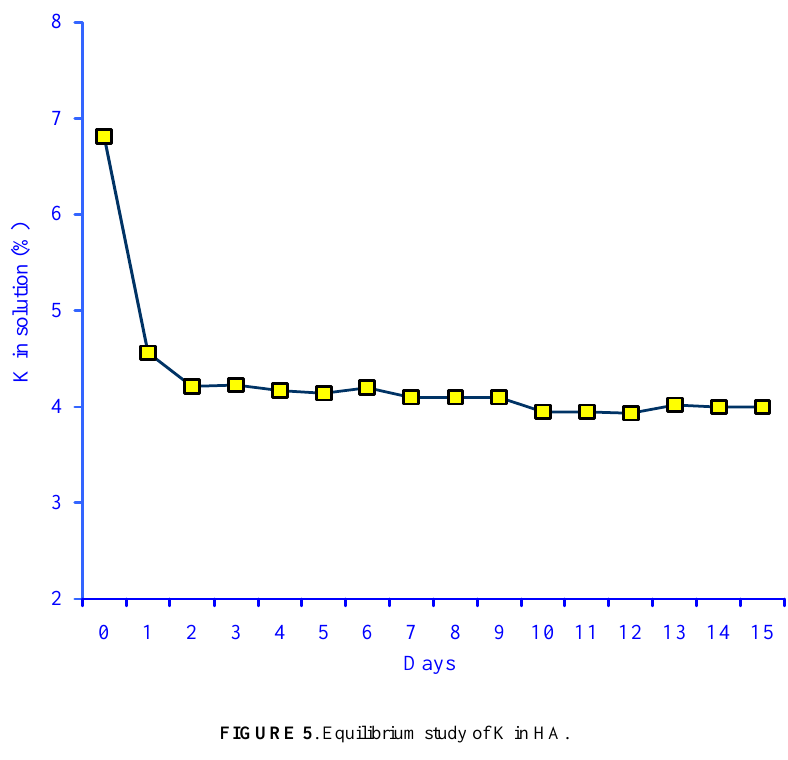
FIGURE 5 . Equilibrium study of K in HA.